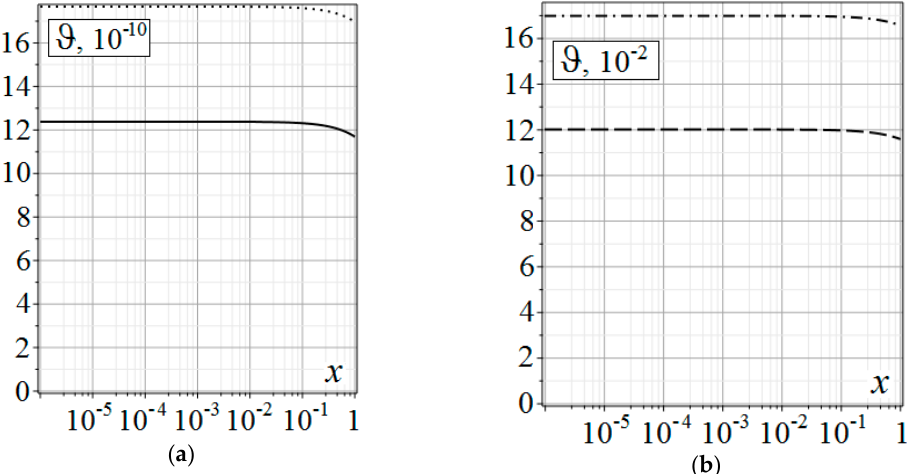
Figure 4. Temperature increment ϑ on x . ( a ) Implantation; and ( b ) annealing.